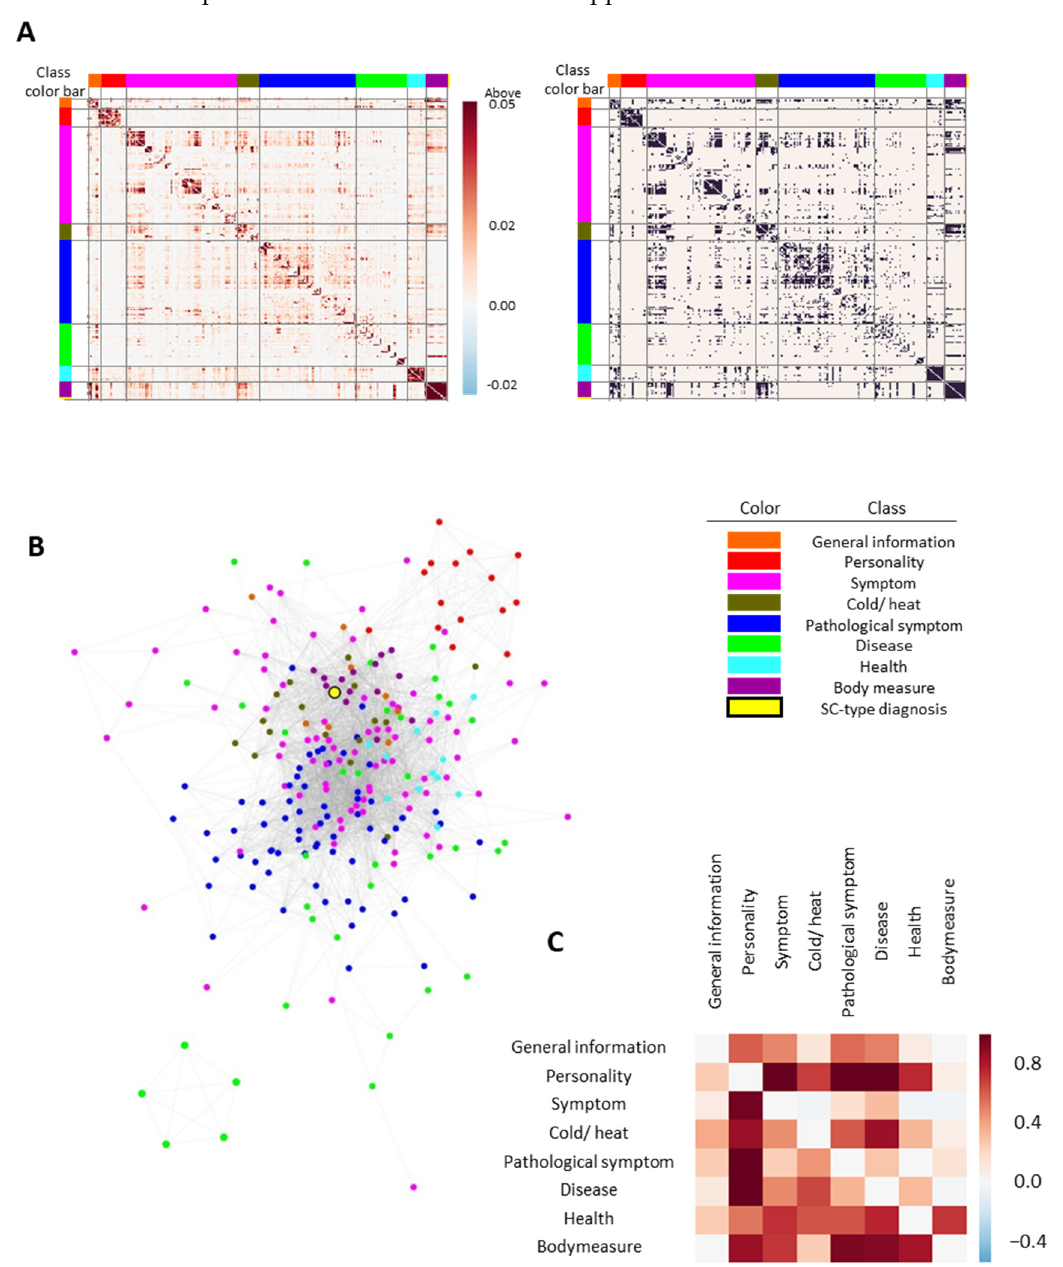
Figure 2. Construction and visualization of the feature network: ( A ) the association matrix between clinical features or SC types. Each feature in the heatmap is ordered according to its feature class. Data were visualized as raw adjusted mutual information (MI) values ( left ) or whether values ex- ceeded the excess cutoff value ( right ); ( B ) visualized feature networks. Class color bar in the heatmap and the node color in the feature network indicate the feature class. Specifically, the yellow circle with black outline represents the SC-type diagnosis. The edges between nodes indicate that the MI value between features is greater than the cutoff value (0.01); ( C ) feature network separation between feature classes. Positive separation values indicate that two classes are well-distinguished at the network level, while negative values imply overlapping between two classes. To describe the clinical characteristics of our network, we further investigated the associations between SC types and representative chronic diseases, such as hypertension, hyperlipidemia, diabetes, obesity, and cancer (Table 3). Generally, the adjusted MI of re- lated features may seem slightly low; however, most related features show a statistically significant association with chronic diseases. However, related features associated with